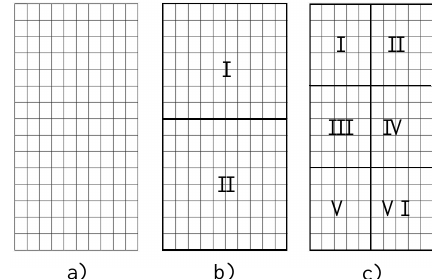
Figure 13. The coupling interface and interpolating schemes. ( a ) the coupling interface; ( b ) scheme with 6 interpolation basic nodes; ( c ) scheme with 12 interpolation basic